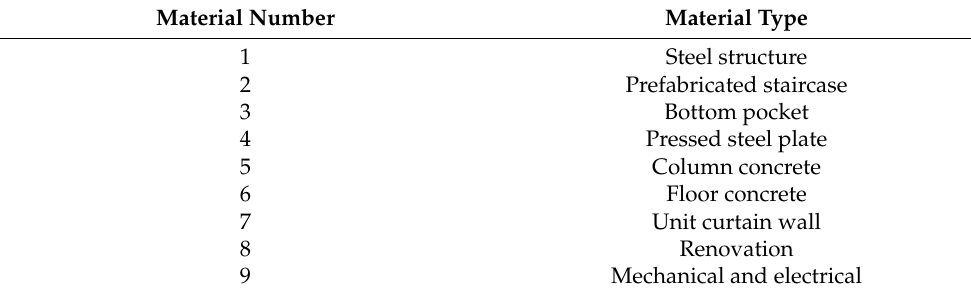
Table 2. Material number